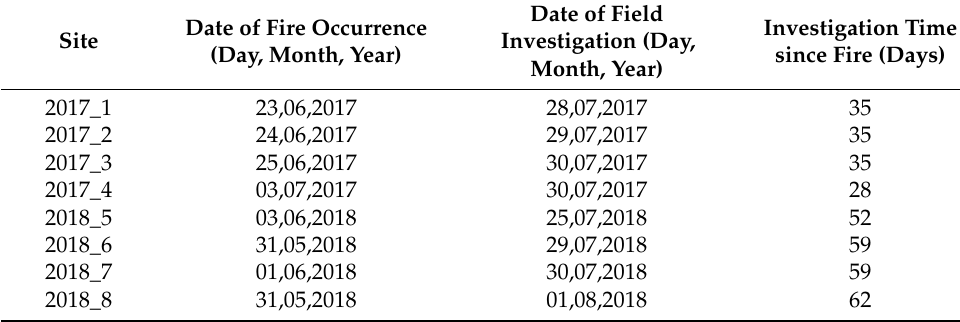
Table 1. Dates of wildfire occurrences and